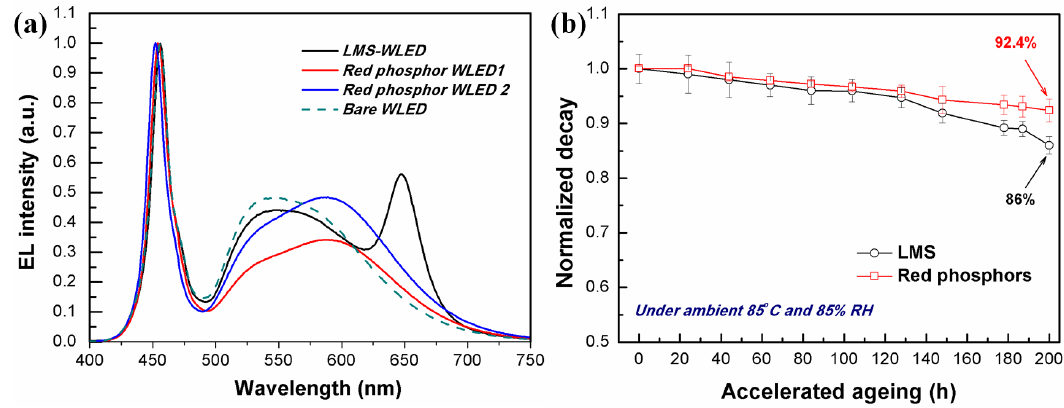
Figure 7: (a) EL spectra of LMS–WLED, red phosphors-optimized WLEDs and bare WLED at 20mA applied current. (b) Normalized decay curves of LMS–WLED and red phosphors-based WLED for accelerated ageing process at 85°C and 85% relative humidity. EL: electrolumi- nescence; LMS-WLED: luminescent microspheres-white light emitting